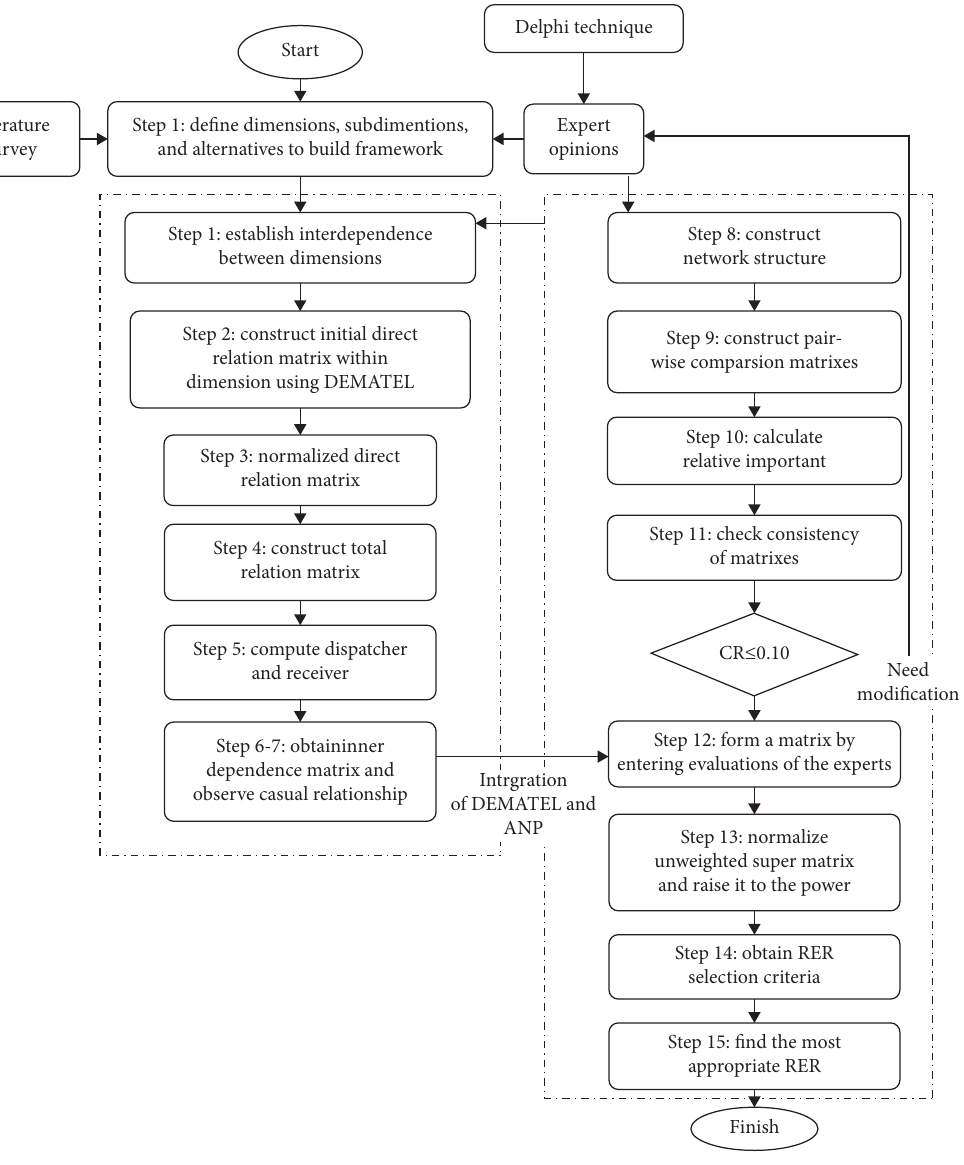
Figure 1: Overview of the integrated DEMATEL and ANP